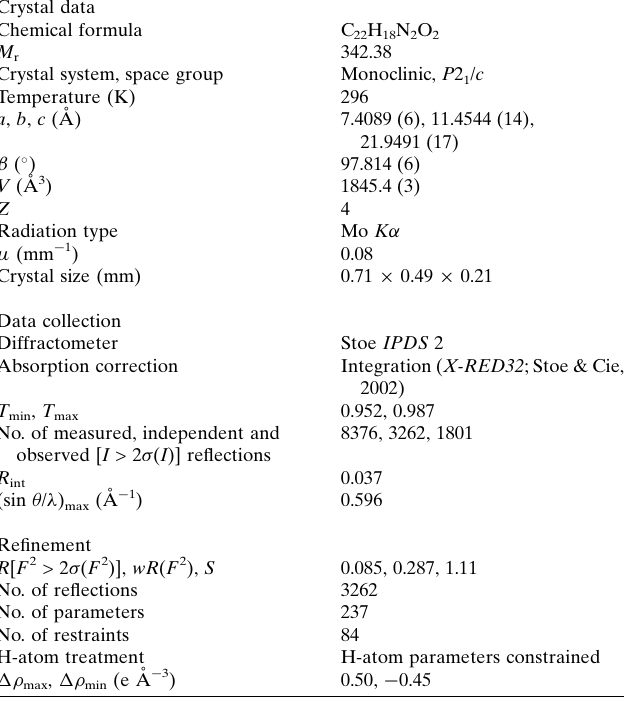
Table 2 Experimental details.